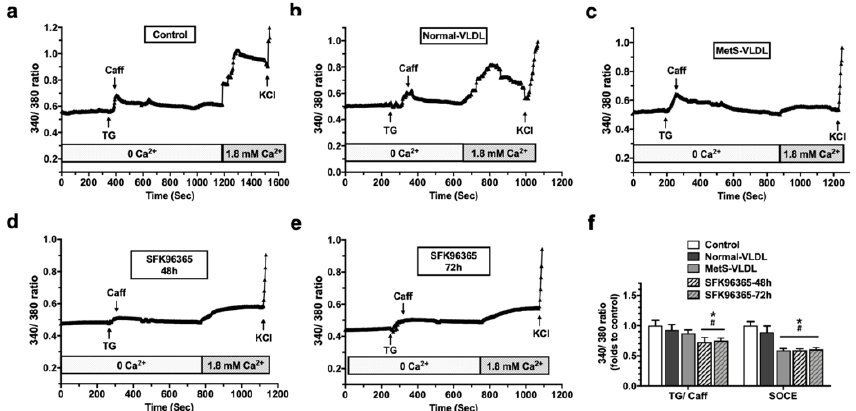
Figure 2. Suppressed store-operated Ca 2+ entry (SOCE) following sarcoplasmic reticulum (SR) Ca 2+ depletion in MetS-VLDL-treated HL-1 cardiomyocytes. ( a – c ) Representative ratiometric tracings in fluorescence measurements in control, normal-VLDL, and MetS-VLDL-treated HL-1 cells during SOCE testing. ( d – e ) Representative ratiometric tracings from STIM-1 inhibited HL-1 cells. SKF 96365, a STIM1 inhibitor. ( f ) Analysis of data from the ratiometric fluorescence 340:380 ratio for the peak response to thapsigargin / ca ff eine (TG / Ca ff ) ( n = 5 experiments; $ P = 0.024, # P < 0.001, * P < 0.01, all vs. control) and the peak of SOCE ( n = 5 experiments; all # P < 0.001 vs. control; all * P < 0.001 vs.